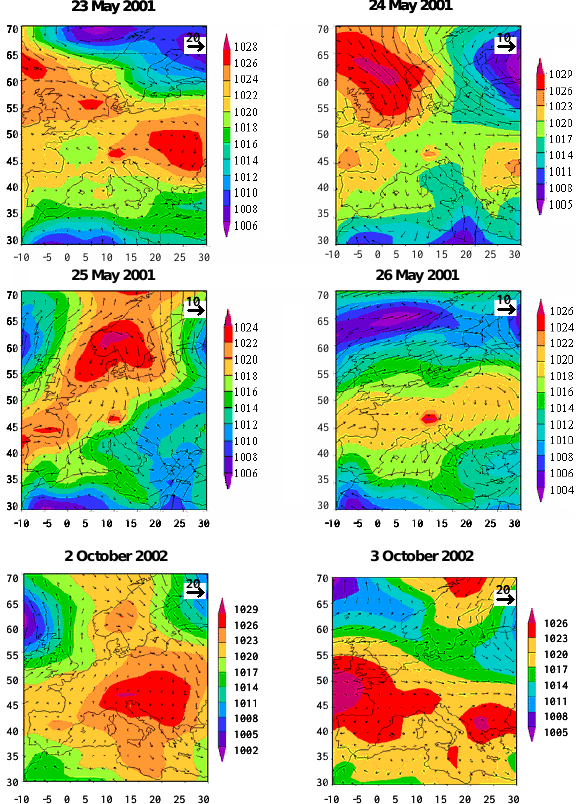
Fig. 2. Meteorological maps showing mean sea-level pressure (in hPa) and wind speed (in ms − 1 ) at 850hPa for each day of the CAATER campaigns at 12:00:00h UTC (http://weather.ou.edu/ ∼ cgodfrey/reanalysis/). Latitude (vertical scale) is given in ◦ N and longitude (horizontal scale) in ◦